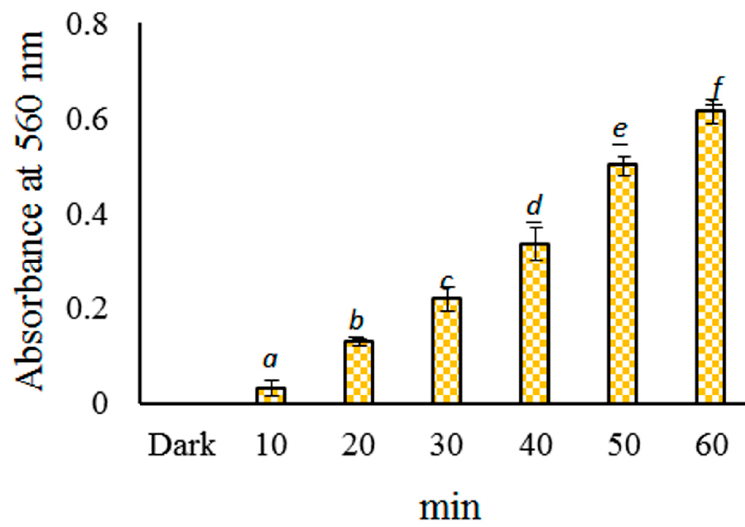
Figure 4. Effects of 290 μ g/mL CHPB on nitro blue tetrazolium (NBT) reduction by blue light-emitting diode (LED) irradiation at 2.0 mW/cm 2 for 10–60 min. Data are represented by mean ± standard deviation, where n = 3. Significant differences ( p < 0.05) between each treatment are indicated by the different letters above the bar.